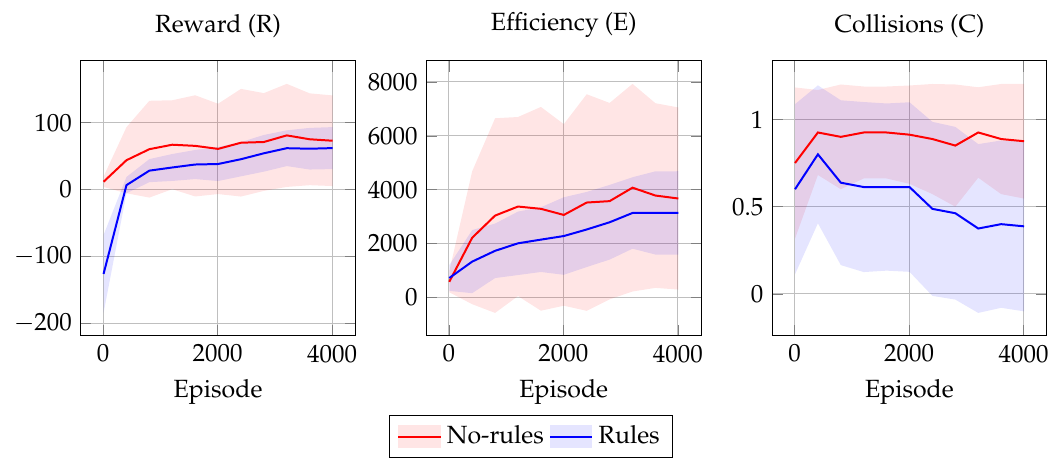
Figure 4. Training results with cars removed after t dead time steps. Here, we draw the training values of R , E , and C , at a certain training episode, averaged on n trial experiments. We indicate with solid lines the mean of R , E , and C among the n car vehicles, and with shaded areas their standard deviation among the n car vehicles.